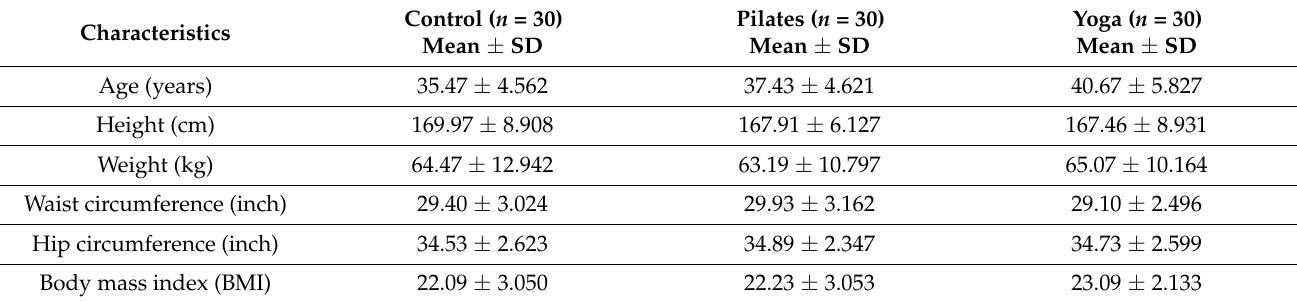
Table 1. Characteristics of participants at pretreatment.